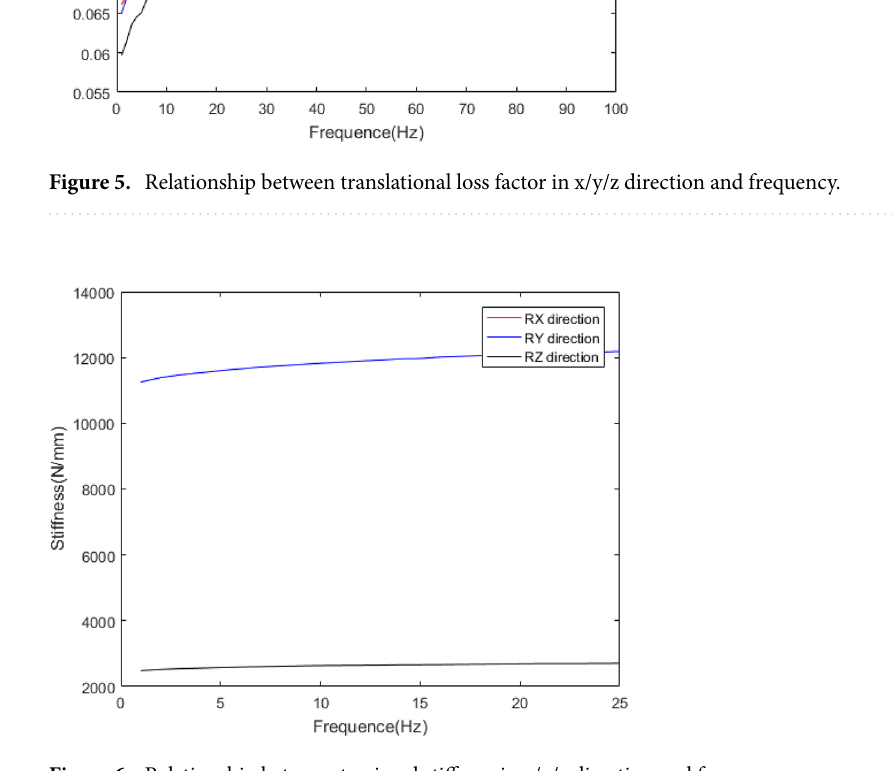
Figure 6. Relationship between torsional stiffness in x/y/z direction and